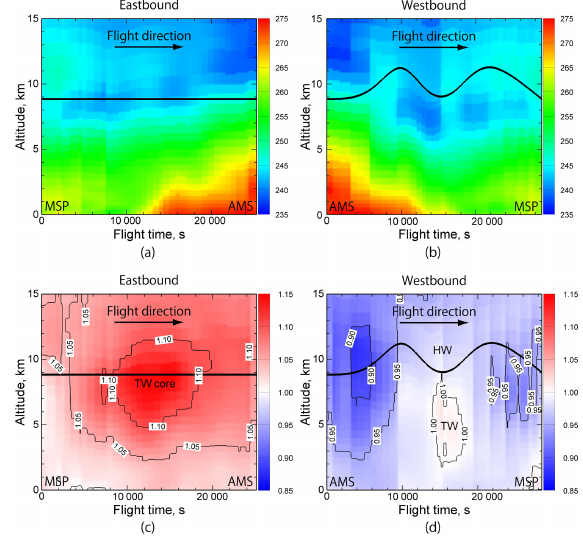
Figure 15. Altitude distributions of the true air speed V TAS in ms − 1 (a, b) and the tail wind indicator V ground /V TAS (c, d) along the time-optimal flight trajectories (black line) between MSP and AMS. Note that (V ground /V TAS ) ≥ 1 . 0 means tail winds (TW, red), while (V ground /V TAS ) < 1 . 0 means head winds (HW, blue) in the flight direction. The contours were obtained at the departure time: 21:35:00UTC (eastbound, a, c ); 12:50:00UTC (westbound, b, d